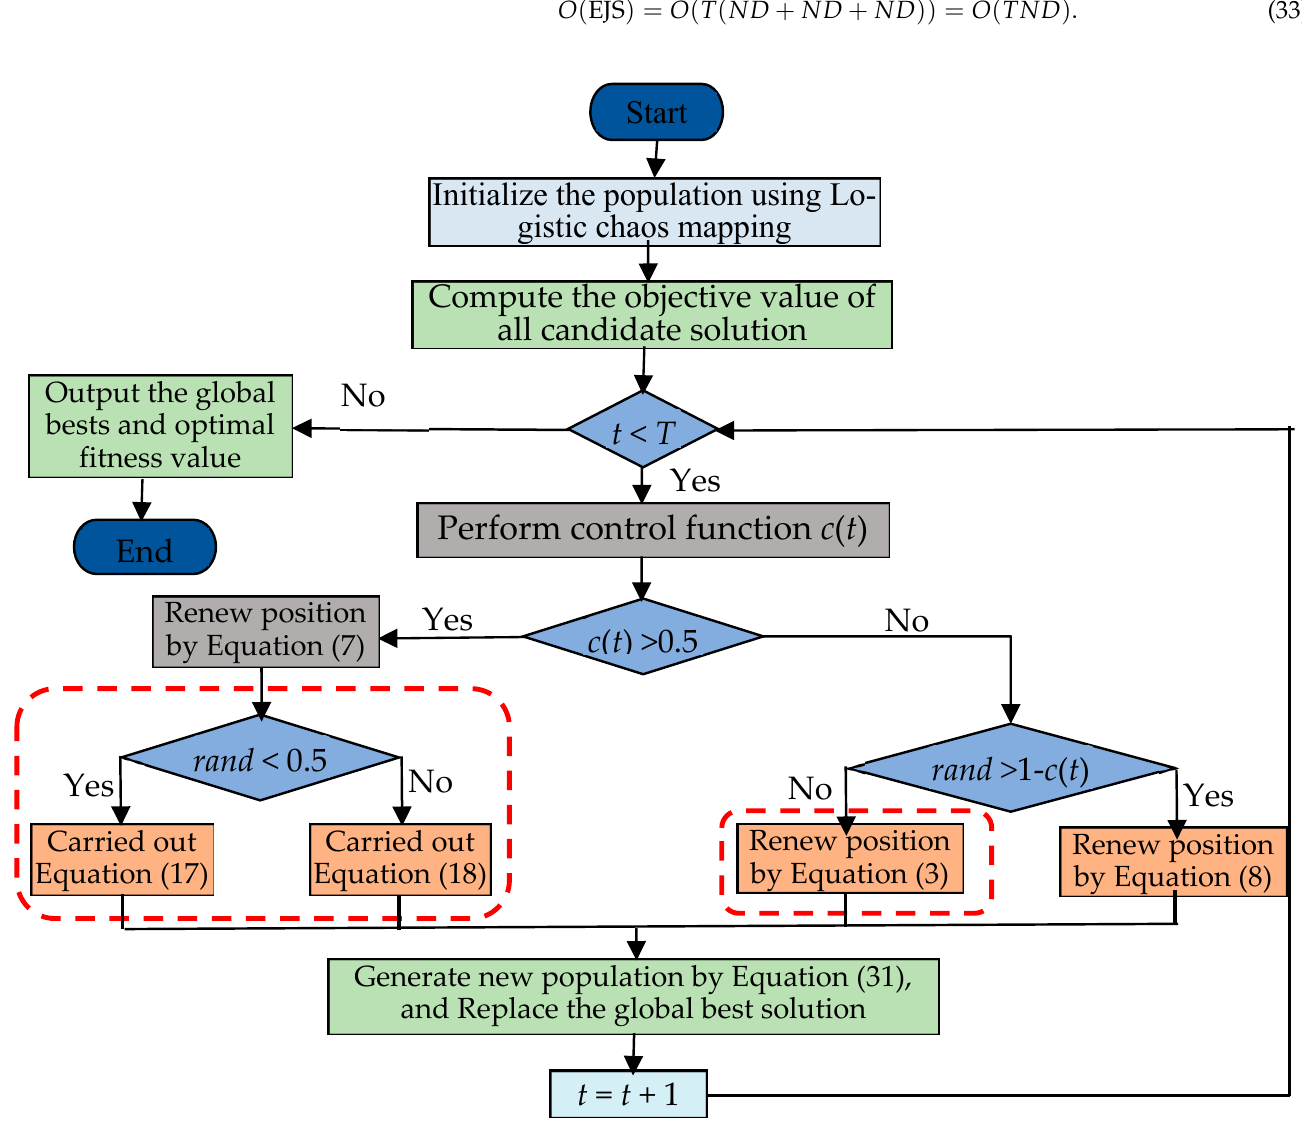
Figure 2. Flow chart of the EJS algorithm.